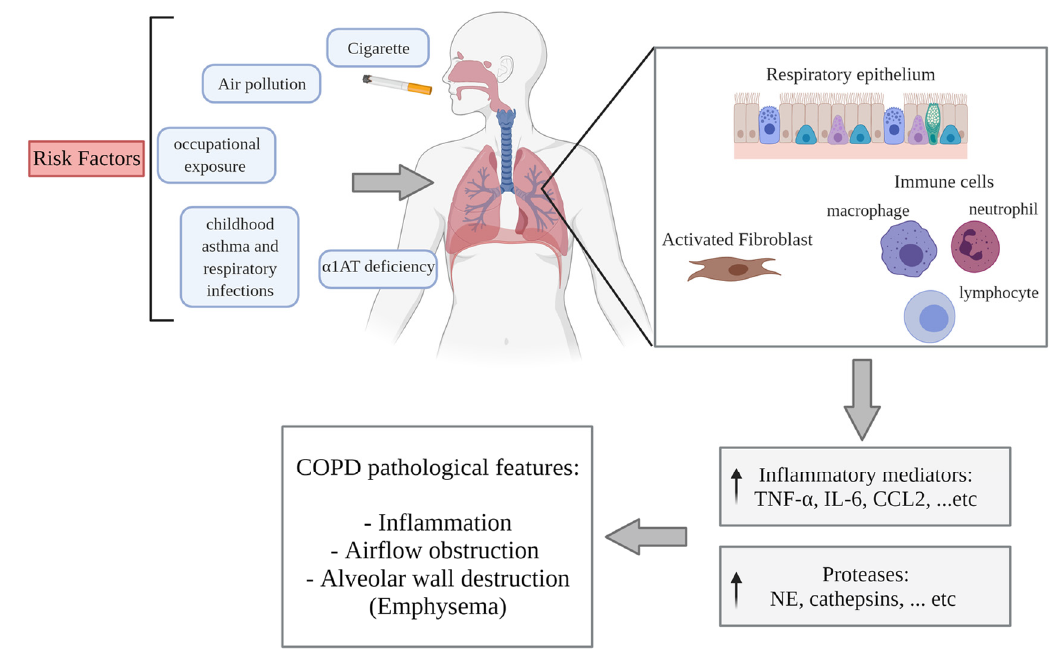
Figure 2. Overview of the etiology and pathogenesis of COPD. Risk factors for the development of COPD include: cigarette smoke; air pollution; occupational exposures; childhood asthma; respiratory infections; and alpha 1-anti-trypsin ( α 1AT) deficiency. Upon exposure to inhaled toxicants, lung structural cells, including epithelial cells and fibroblasts, as well as alveolar macrophages, are activated. These cells produce inflammatory mediators to recruit additional inflammatory cells, such as neutrophils, macrophages, and lymphocytes, to the site of exposure. This augments the expression of inflammatory mediators, such as TNF- α , IL-6, CCL2, CCL7, CXCL1, CXCL5, CXCL8 (IL-8), LTB4, and COX-2, and releases proteases, such as NE, cathepsins, and MMPs. This cascade of events can lead to chronic pulmonary inflammation, airflow obstruction, and alveolar wall destruction (emphysema) in a susceptible individual. Created with BioRender.com.